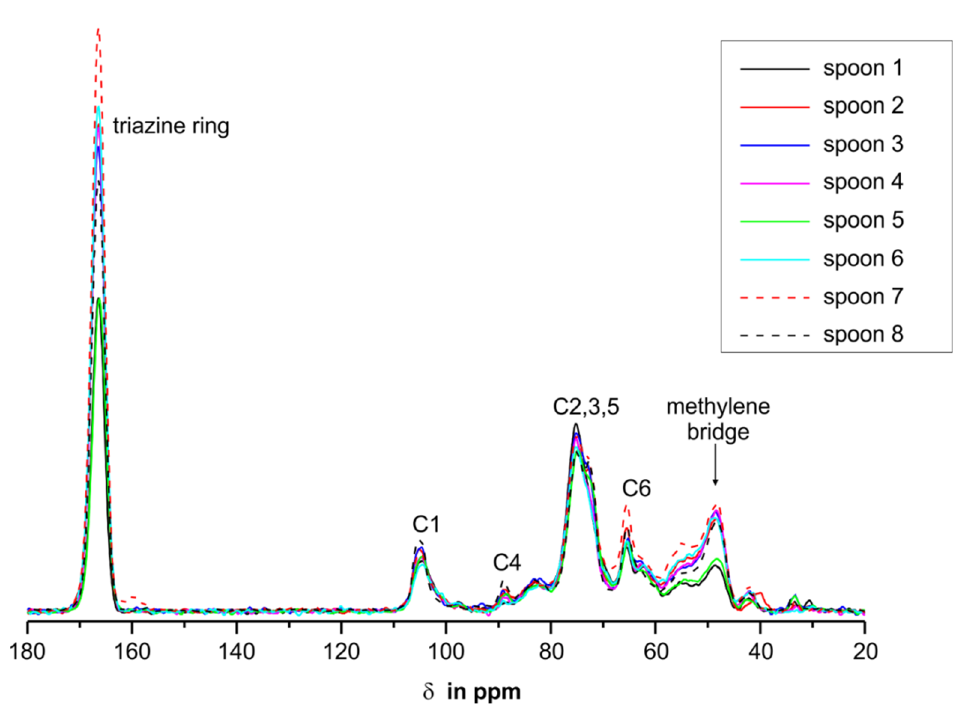
Figure 8. Overlay CP/MAS 13 C-NMR spectra of the spoons 1–8. For better comparability, the spectra are scaled to the area of the signal of the cellulose C1.